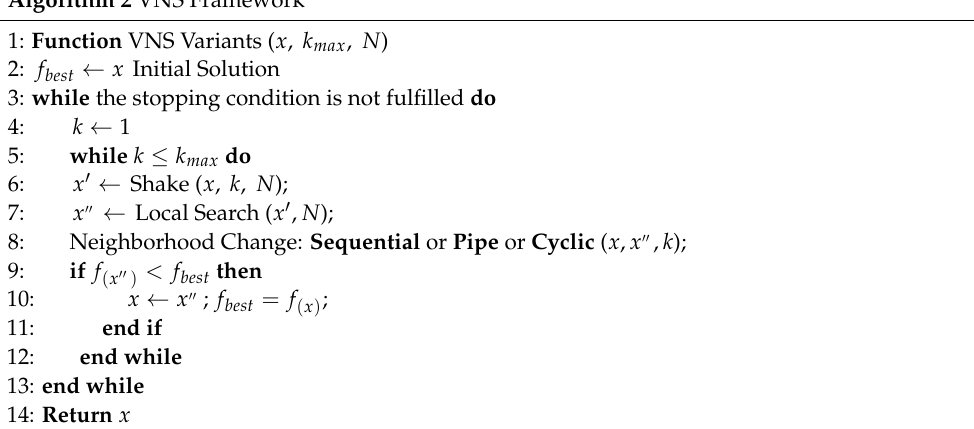
Algorithm 2 VNS Framework